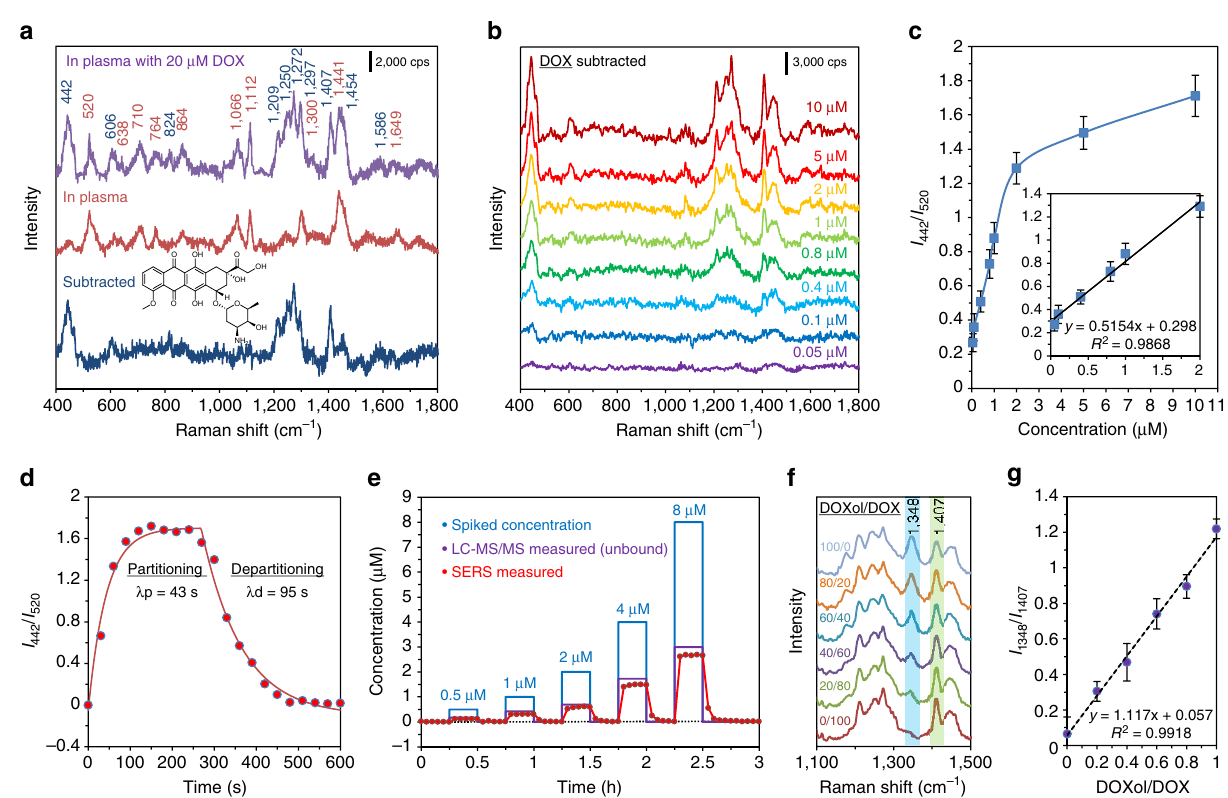
Figure 3 | Real-time quantitative monitoring of DOX in undiluted human plasma using the pCBAA-modified SERS optofluidic system. ( a ) SERS spectra of undiluted plasma spiked with 20 m M DOX, plasma and the subtracted spectrum. l ex ¼ 785nm, P laser ¼ 1mW and t ¼ 30s with three accumulations. ( b ) Subtracted SERS spectra of DOX in plasma ultrafiltrate (UF) control at concentrations ranging from 0.05 to 10 m M. ( c ) DOX detection curve generated by plotting the average intensity ratio of the peaks at 442 and 520cm (cid:2) 1 as a function of the DOX concentration. Inset: a linear relationship was found for the physiologically relevant concentrations. The error bar stands for s.d. of three replicates. ( d ) Partitioning and departitioning of 20 m M DOX in plasma on a pCBAA-modified SERS-active surface. l ex ¼ 785nm, P laser ¼ 1mW and t ¼ 10s with one accumulation. The 1/ e time constants were calculated to be 43s for partitioning and 95s for departitioning. ( e ) In vitro real-time monitoring of DOX in undiluted human plasma (red) relative to spiked concentrations (blue) over the course of 3h. The free DOX concentrations in plasma (red dots) were determined from the calibration curve in c . The free DOX concentrations in ultrafiltrated plasma (purple dashed line) were measured using liquid chromatography–mass spectrometry. ( f ) SERS spectra of pure DOXol and DOX, and DOXol/DOX mixtures. ( g ) Average intensity ratios of the peaks at 1,348 and 1,407cm (cid:2) 1 as a function of the DOXol/DOX ratios. The error bar stands for s.d. of three